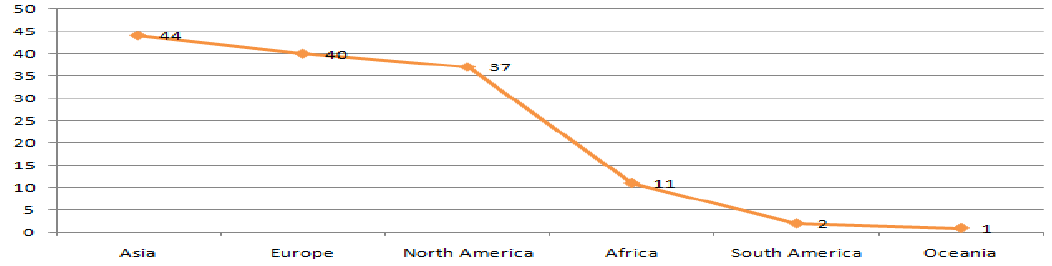
Diagram 2. Article-producing countries based on their continent.